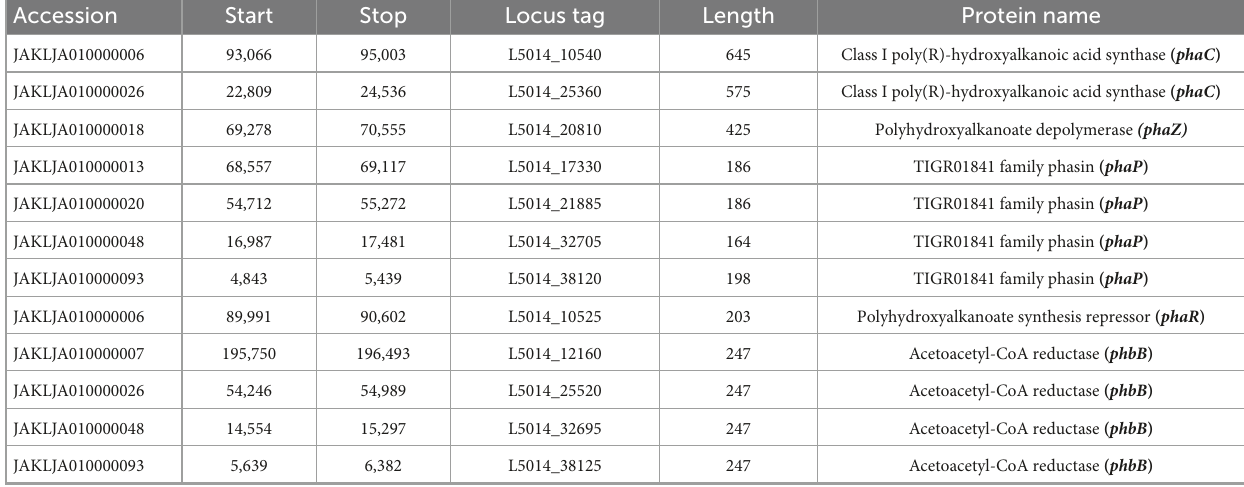
TABLE 5 Annotation of genes responsible for PHB synthesis in strain RG36 T .